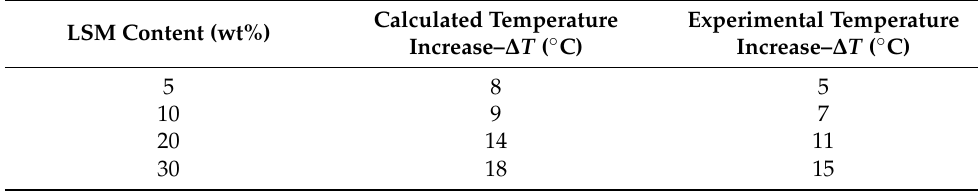
Table 4. Calculated and experimental temperature increase for the tested composites.